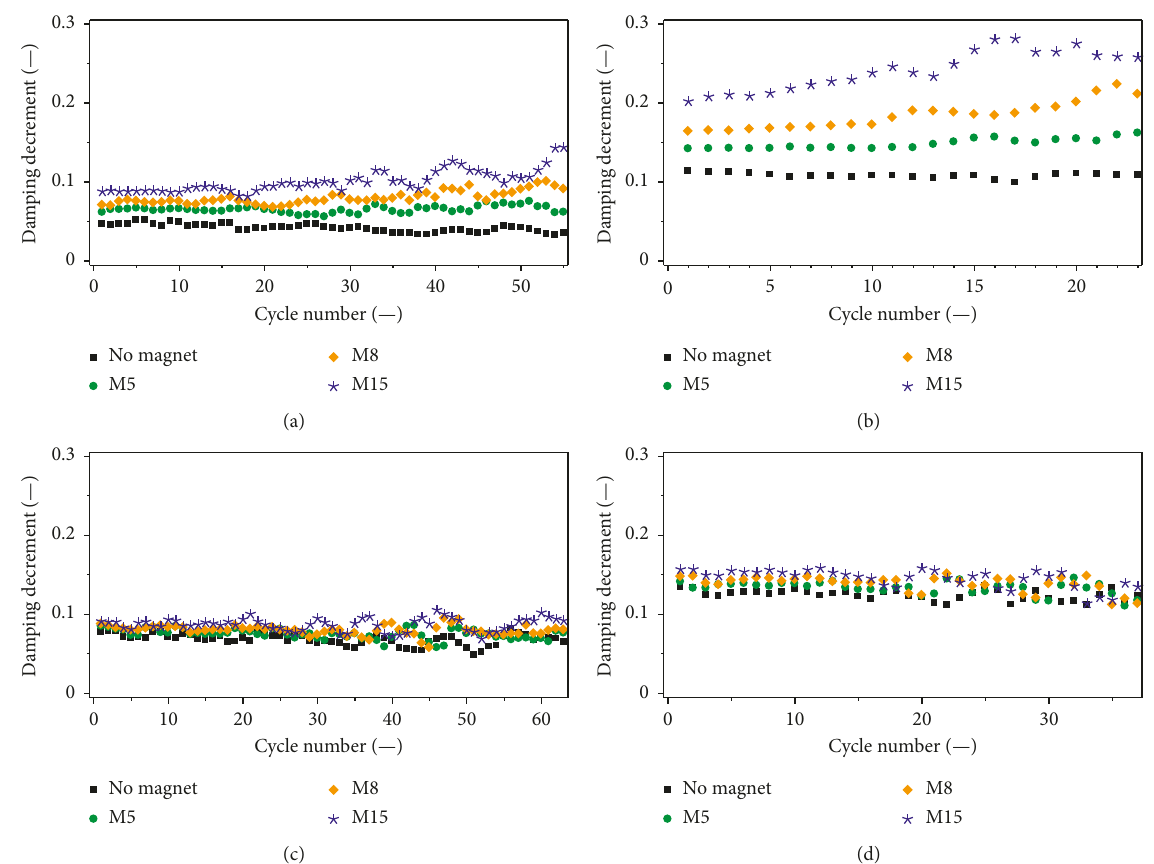
Figure 10: Logarithmic damping decrement of subsequent cycles: (a) MRE 1A, (b) MRE 1B, (c) MRE 2A, and (d) MRE